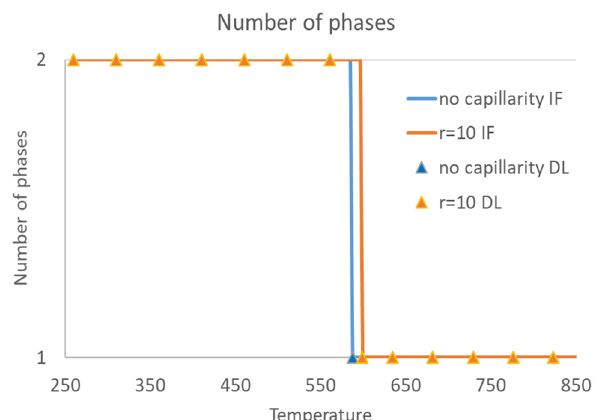
Figure 3. Number of phases at equilibrium changing with temperature under the constant overall mole concentration as 189.85 mol/m 3 mole concentration as 189.85 mol/m 3.